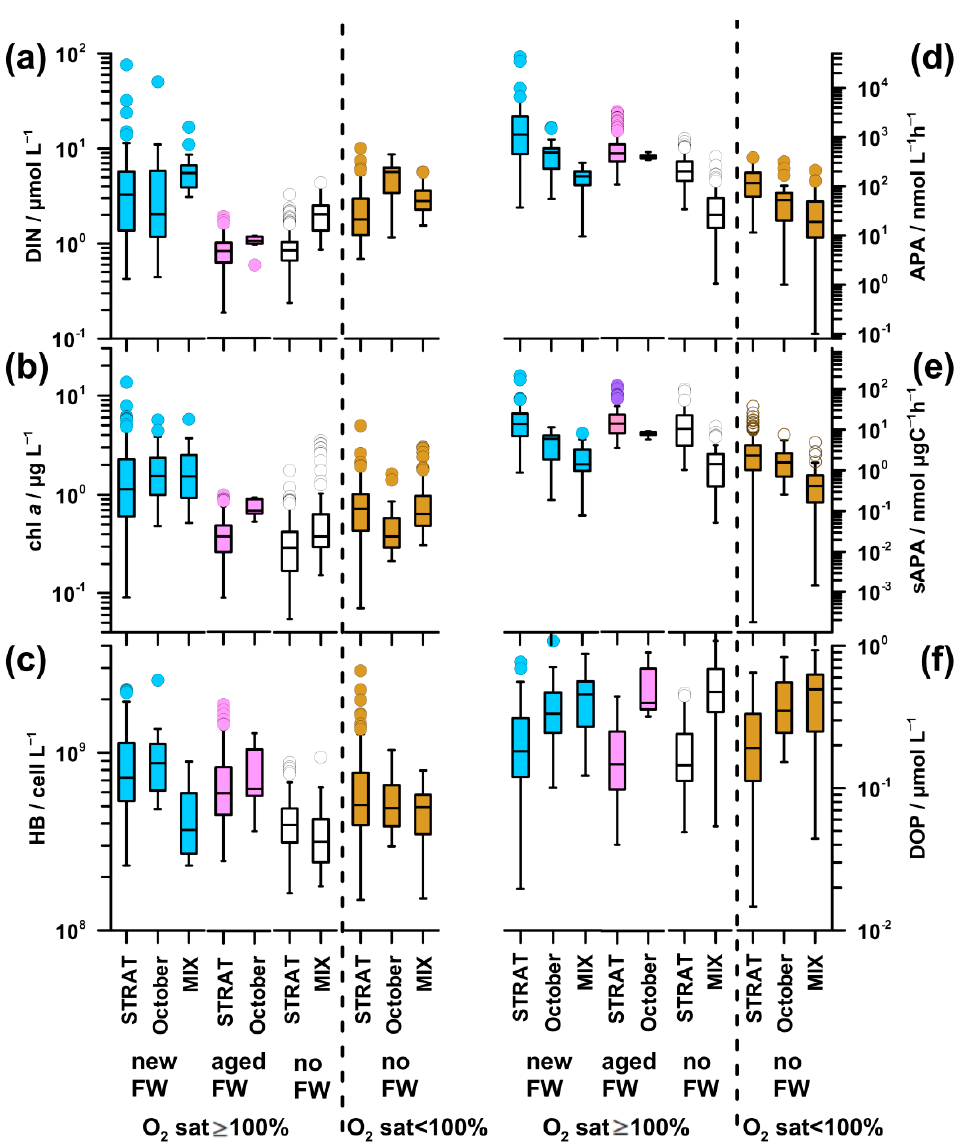
Figure 7. Distribution of ( a ) DIN, ( b ) chl a , ( c ) HB, ( d ) APA, ( e ) specific APA (sAPA), and ( f ) DOP in water types in the Northern Adriatic during 2004–2013. Abbreviations and plot characteristics are reported in Figure 2 and Figure 4. The significance of the differences among the water types (Kruskal–Wallis test) is reported in Appendix A (Table A1).